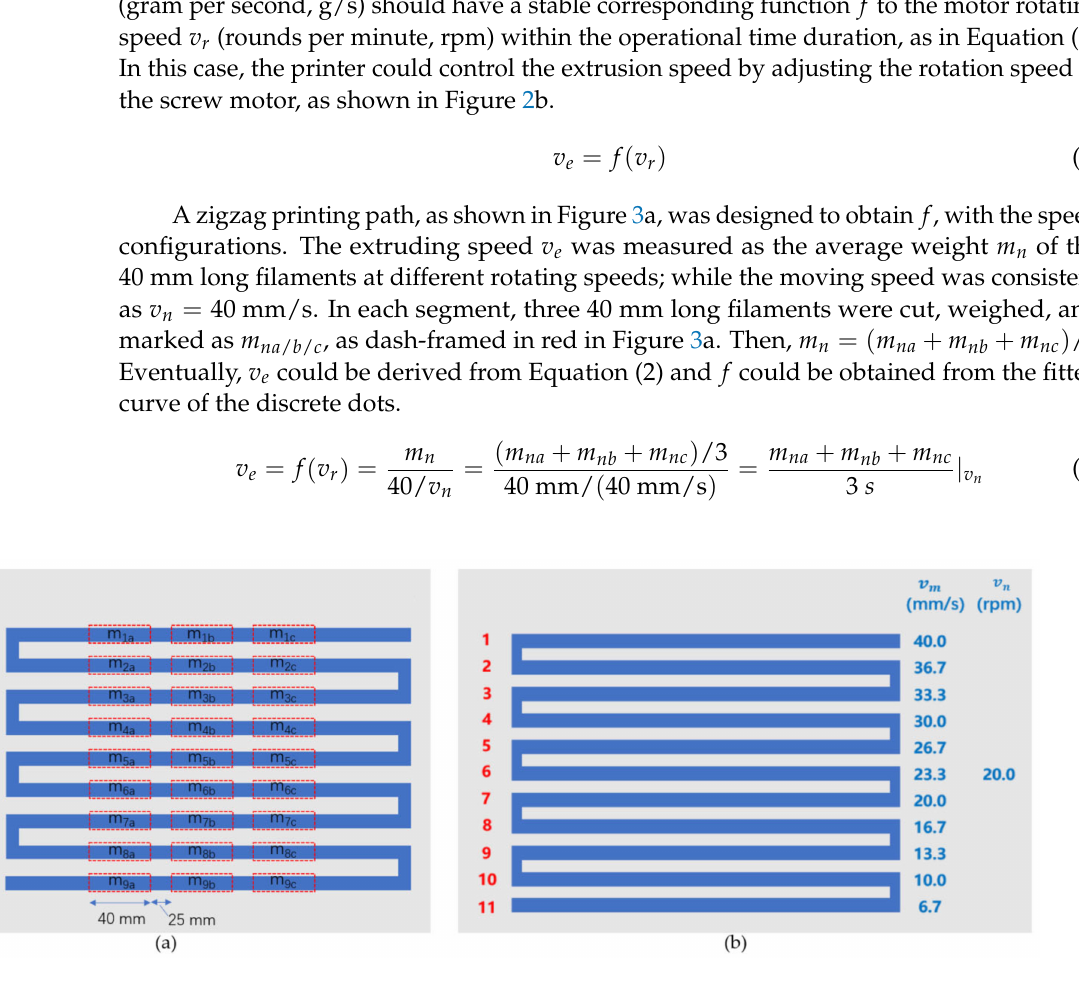
Figure 3. Zigzag paths for printability characterization: ( a ) extrudability test (the cutting tool had two blades fixed at a distance of 40 mm to guarantee the precision cutting operation; red dotted line in the figure indicates the interception position and spacing of the 40 mm long filaments); ( b ) layout ability